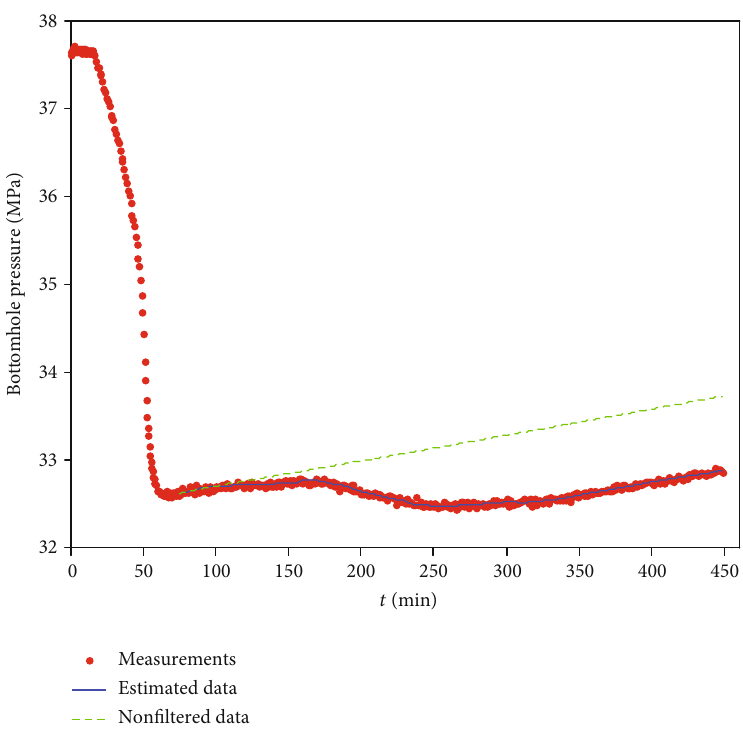
Figure 9: Bottomhole pressure variation (case